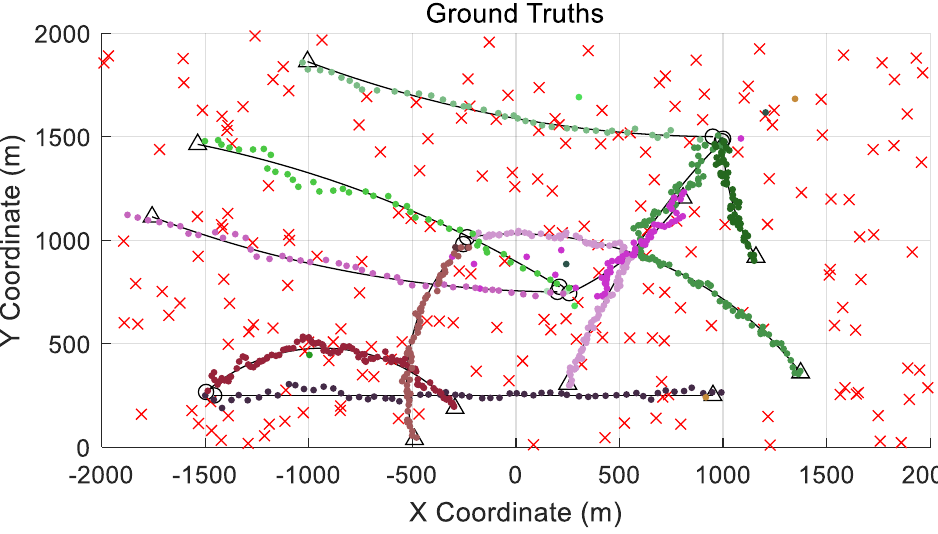
Figure 5. Ground truths for the multiple target tracking scenario and estimated tracks outputted from the corresponding GLMB-TBD filter. The symbol ‘x’ denotes the clutter distribution. The dot lines denote the estimated trajectories. The symbol ‘x’ denotes the clutter distribution.